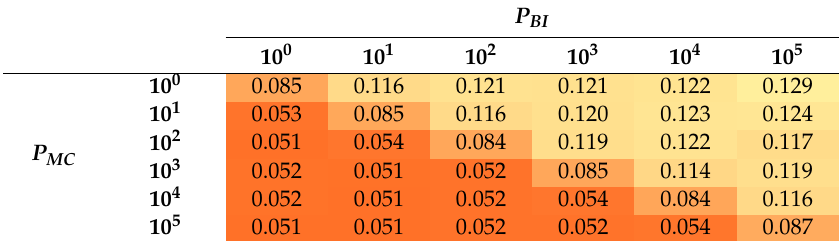
Table 3. Averaged absolute errors of the meshedness coefficient (MC) for different penalty factors. P